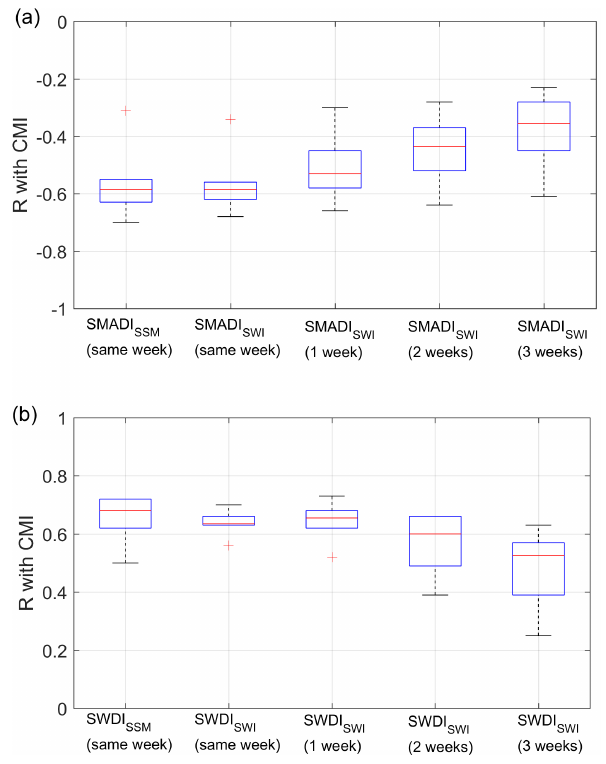
Figure 5. Correlation ( R ) of the SMADI (a) and SWDI (b) obtained using the SMOS SSM and SWI, with the CMI of the same week and 1, 2 or 3 antecedent weeks at the six AEMet stations. Only significant values ( p -value<0.05) were considered.